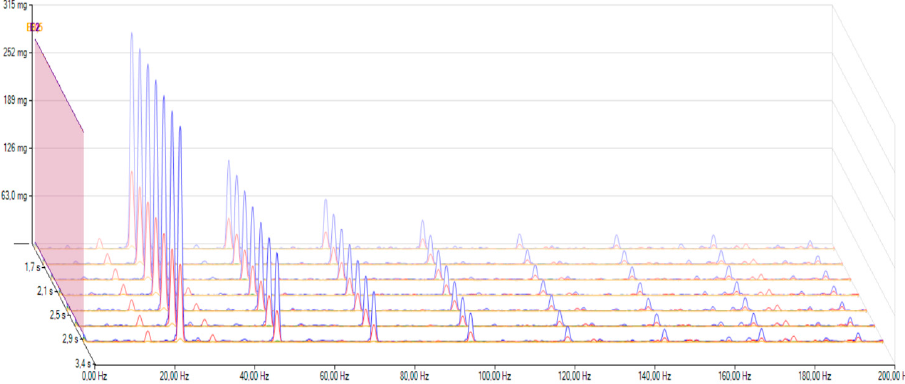
Figure 7. Vibrations in the frequency domain before oil change.